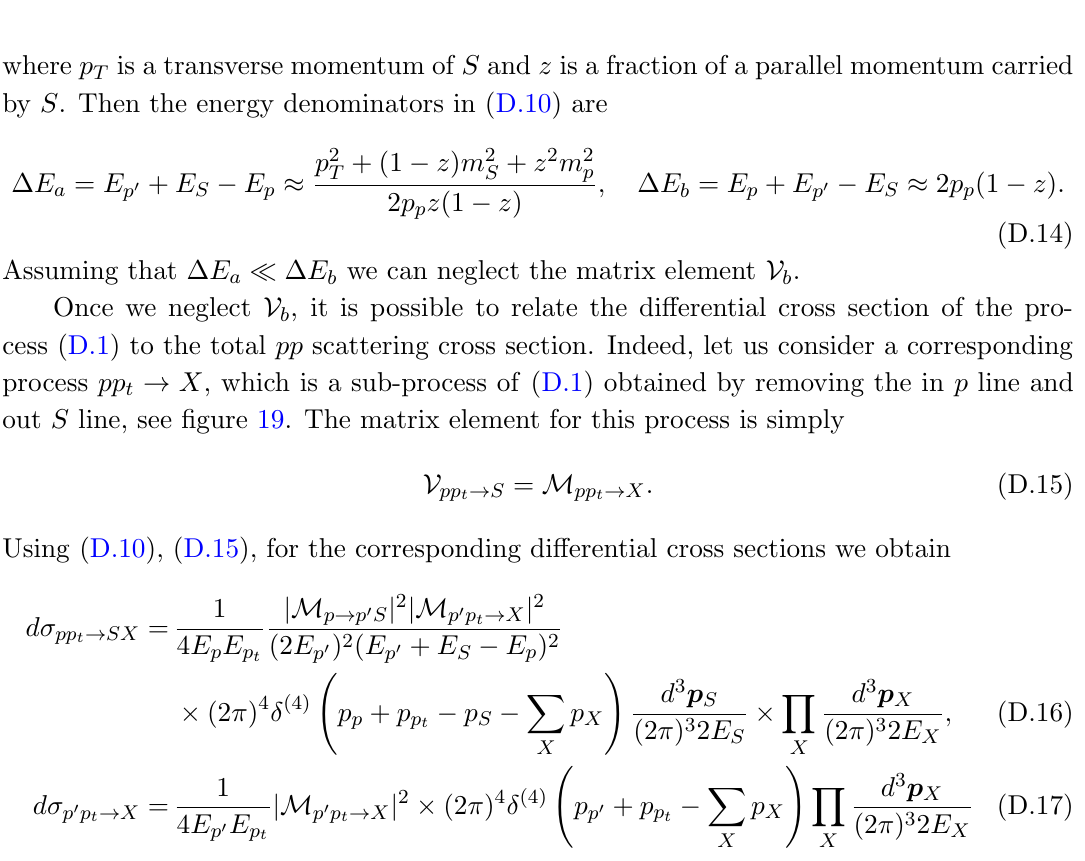
Figure 19 . Diagrams the bremsstrahlung process (D.1) (left) and its sub-process pp t scribing a proton-proton collision